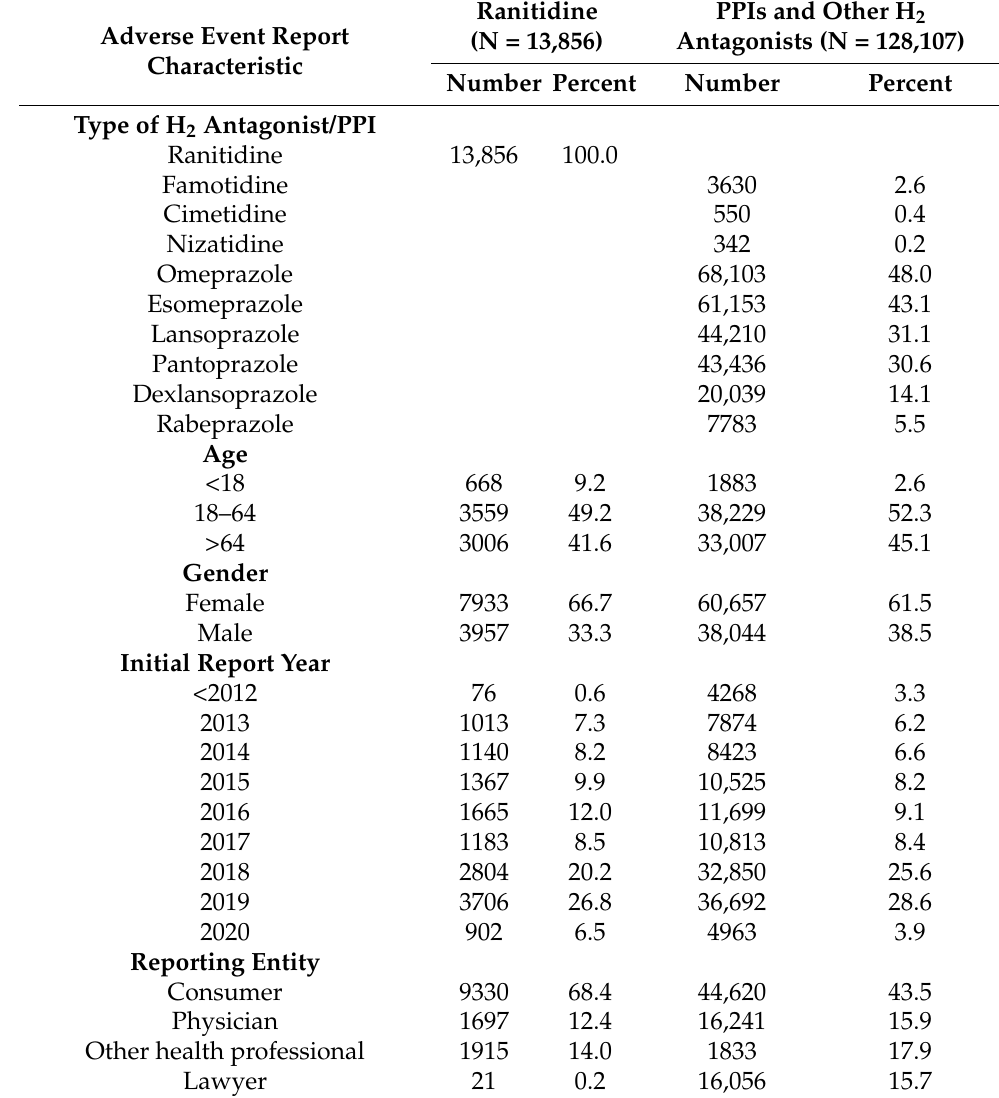
Table 1. Characteristics of adverse event reports for ranitidine and proton pump inhibitors (PPIs) and other H 2